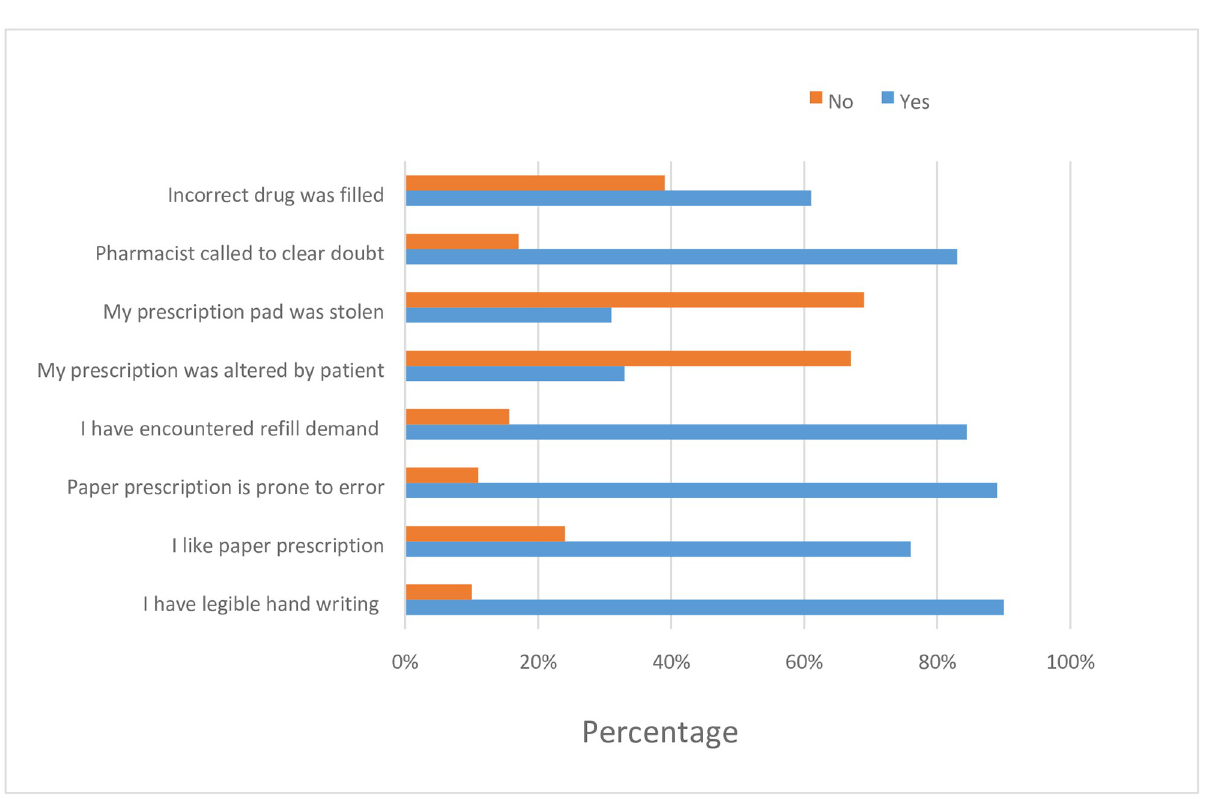
Fig 1. Current prescription profile of participants (N = 301).